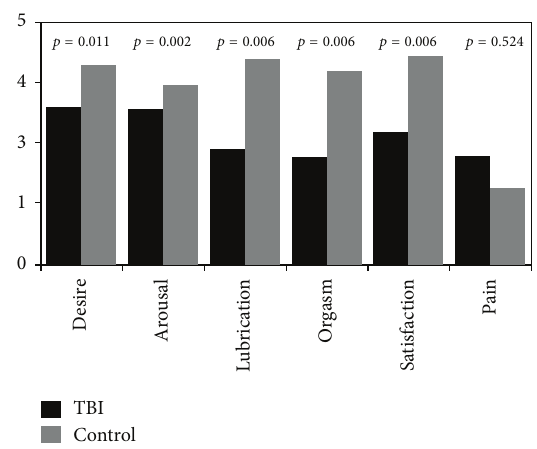
Figure 1: Female Sexual Function Index mean subscale